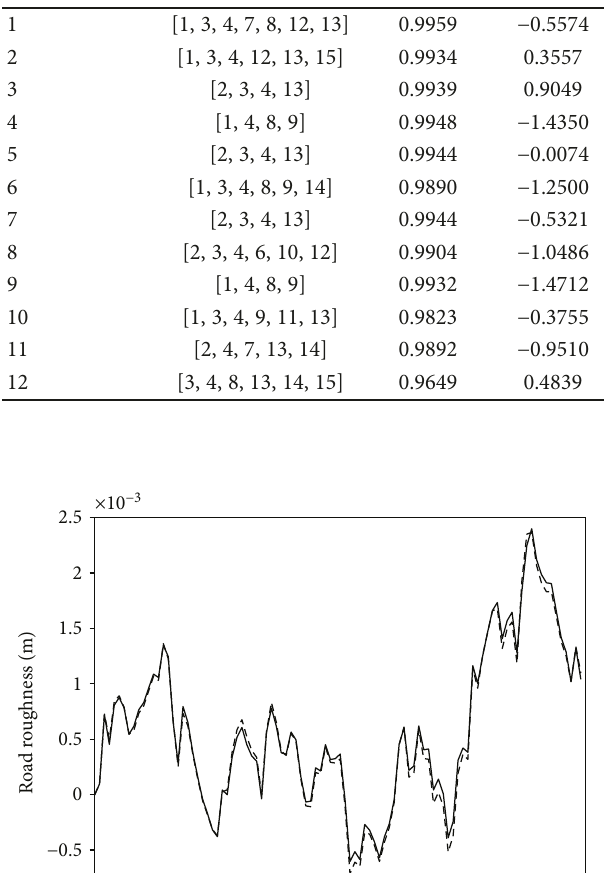
Figure 7: Road roughness estimation results based on the random forest method and features in Experiment